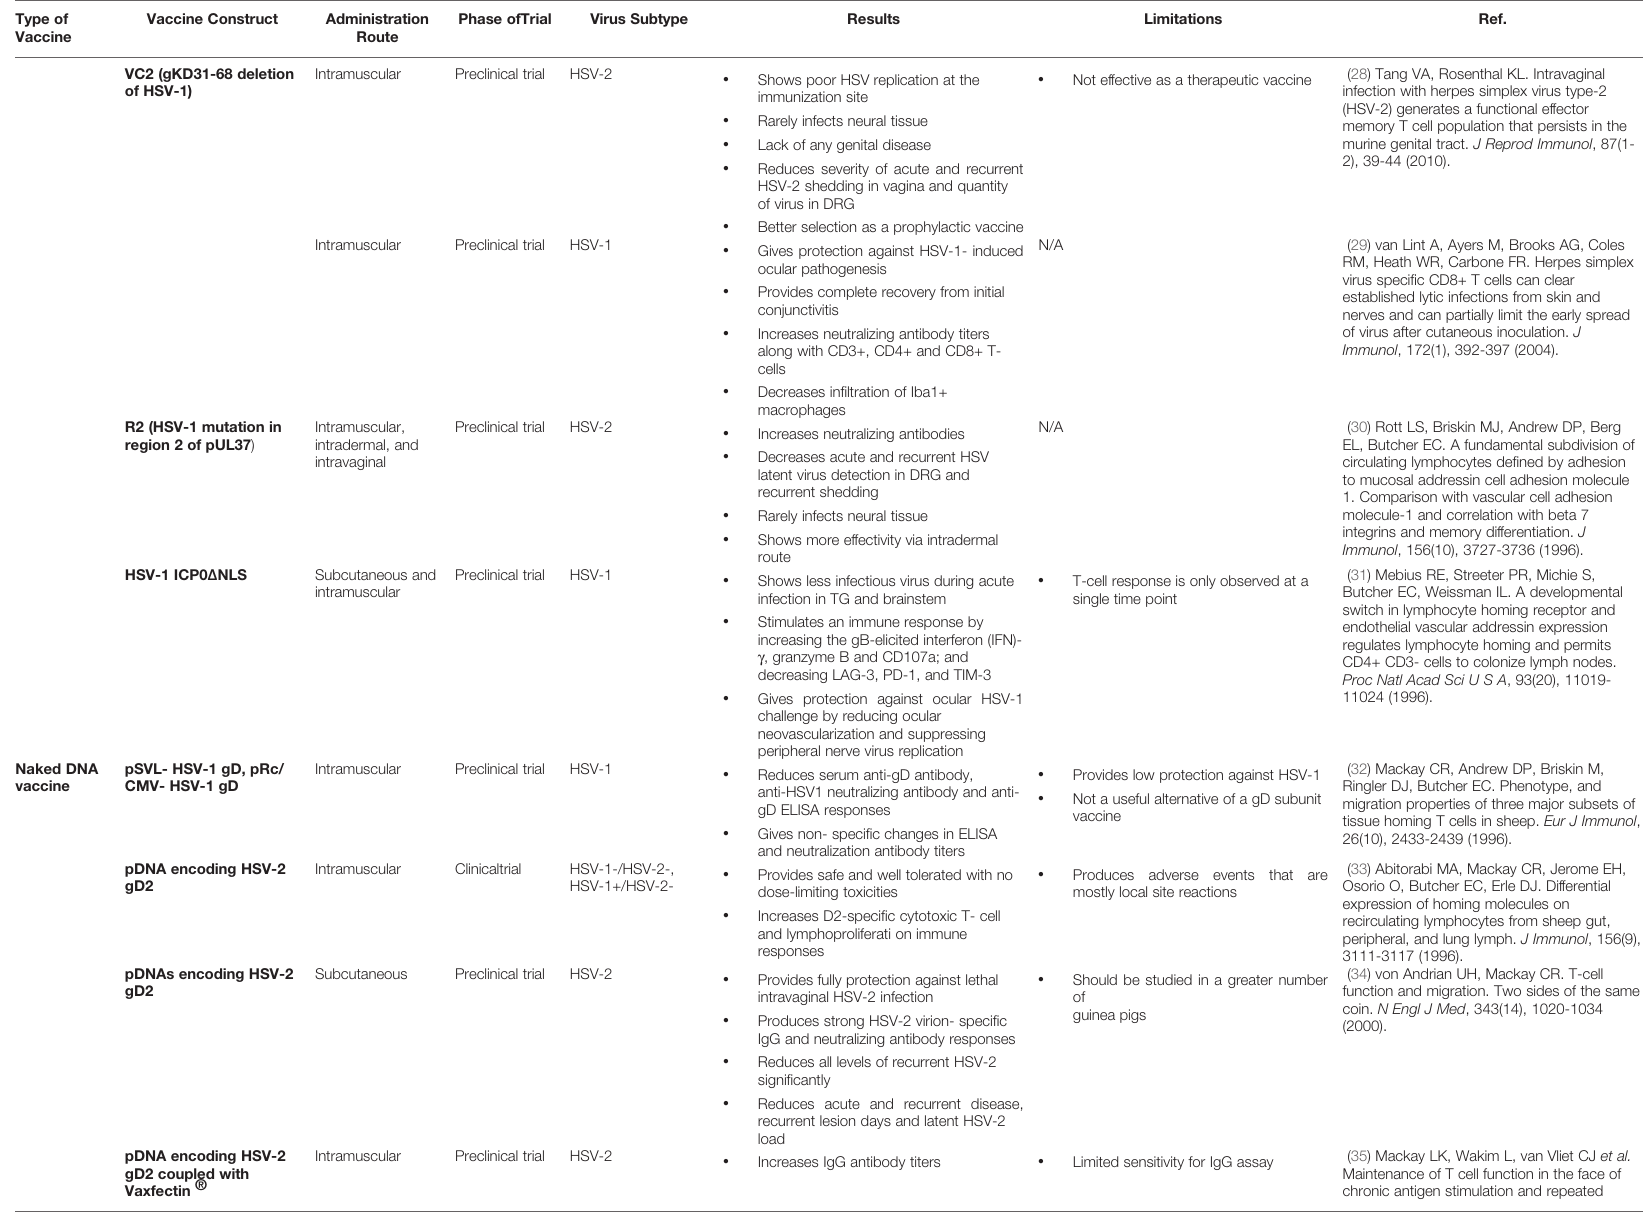
1. Comparison with vascular cell adhesion molecule-1 and correlation with beta